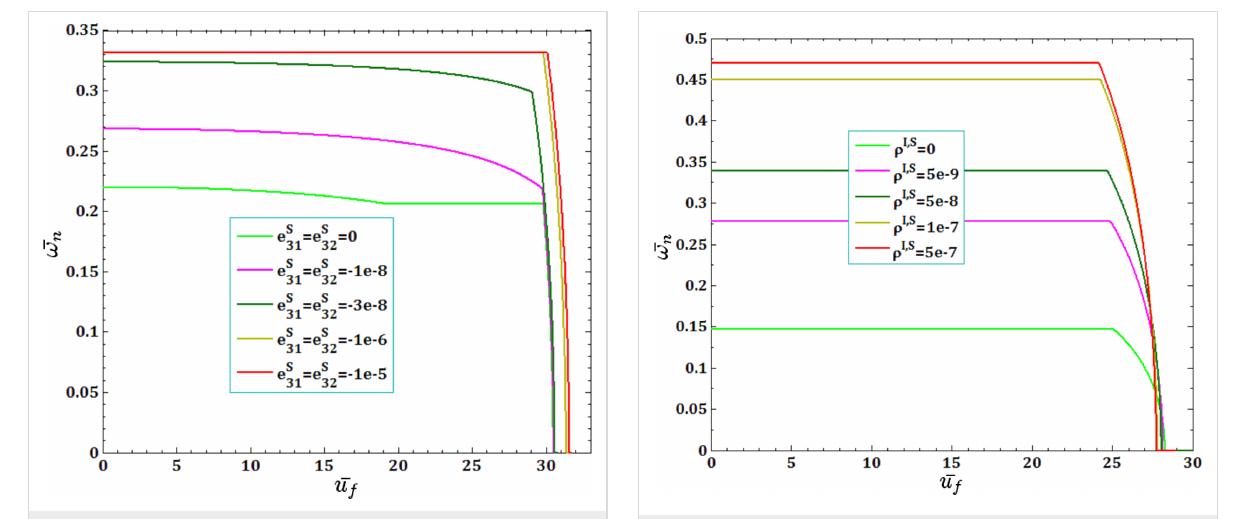
Figure 11: The effects of surface piezoelectricity constants for fluid velocity on DNF of SS FC-MWPENS.